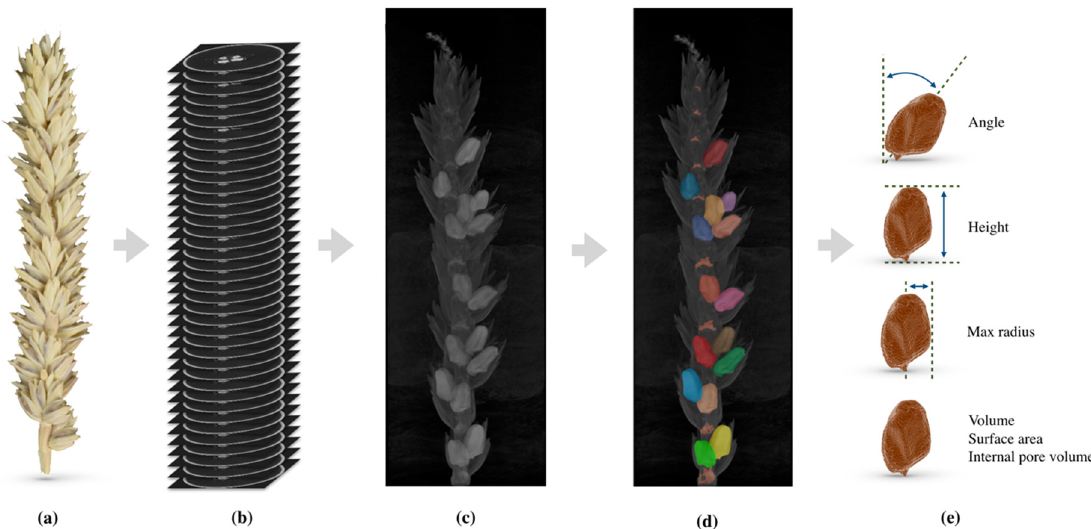
Figure 1. The pipeline of the proposed 3D morphological processing. ( a ) An optical image of a wheat spike [14]; ( b ) Layer by layer scanned CT images of the wheat spike; ( c ) The 3D image from stacked CT images; ( d ) Detected grains and stems by the proposed 3D morphology analysis; ( e ) Extracted 3D phenotypes of the wheat spike. The whole pipeline is done automatically while some parameters are given manually.